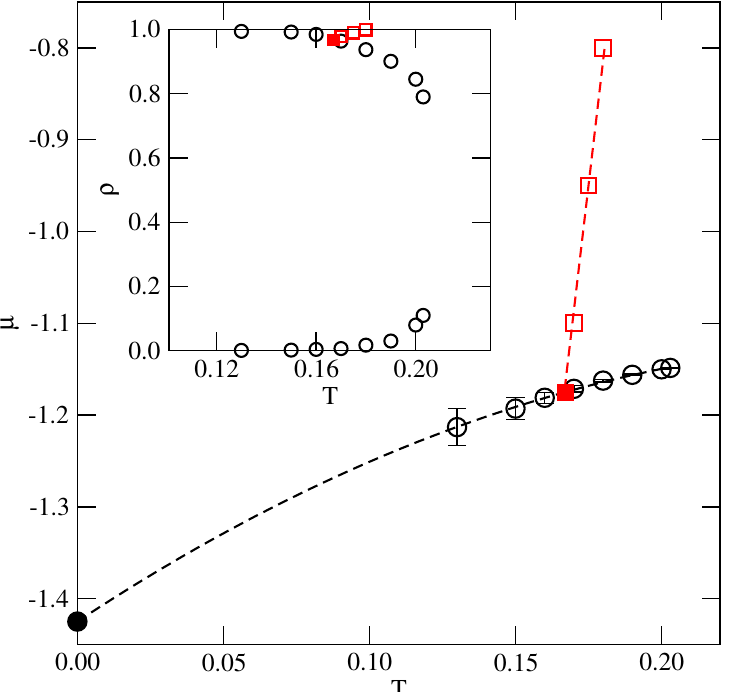
Figure 5. The estimated phase diagram for the system with u | ast = − 0.1. The main part shows the T − µ projection, and the inset gives the T − ρ projection. Circles and squares represent the coexistence points of the first − order and continuous transitions, respectively. The filled square marks the location of the critical end point, while the filled circle (in the main part) shows the location of the first-order transition in the ground